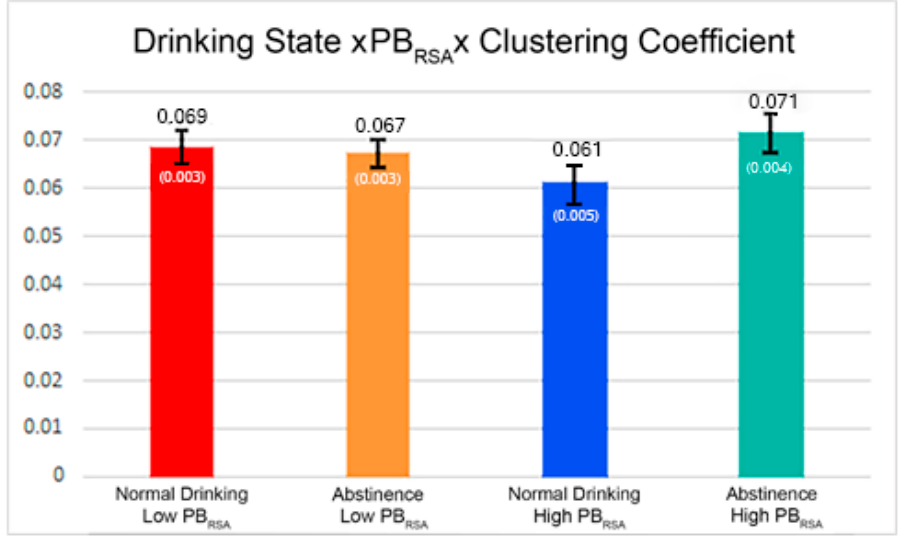
Figure 1. The bars capture the slope of the relationship between clustering coefficient and connection strength, across drinking states and as PB RSA increases. Numbers above the bar are slope values, and numbers in parentheses are standard error. At lower RSA values, there is minimal difference in the relationship between drinking states, whereas at higher PB RSA values, there is a much larger change in the slope of the relationship between clustering and strength.